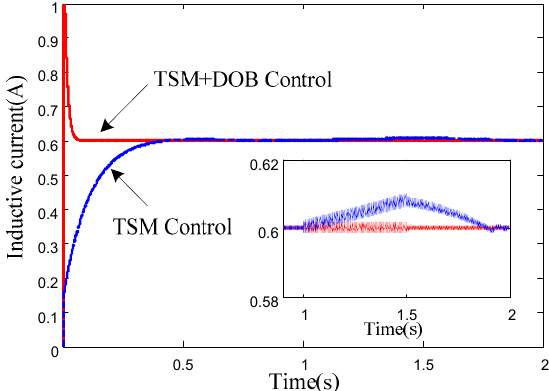
Figure 7. Simulated step-input-voltage waveform of the inductive current.